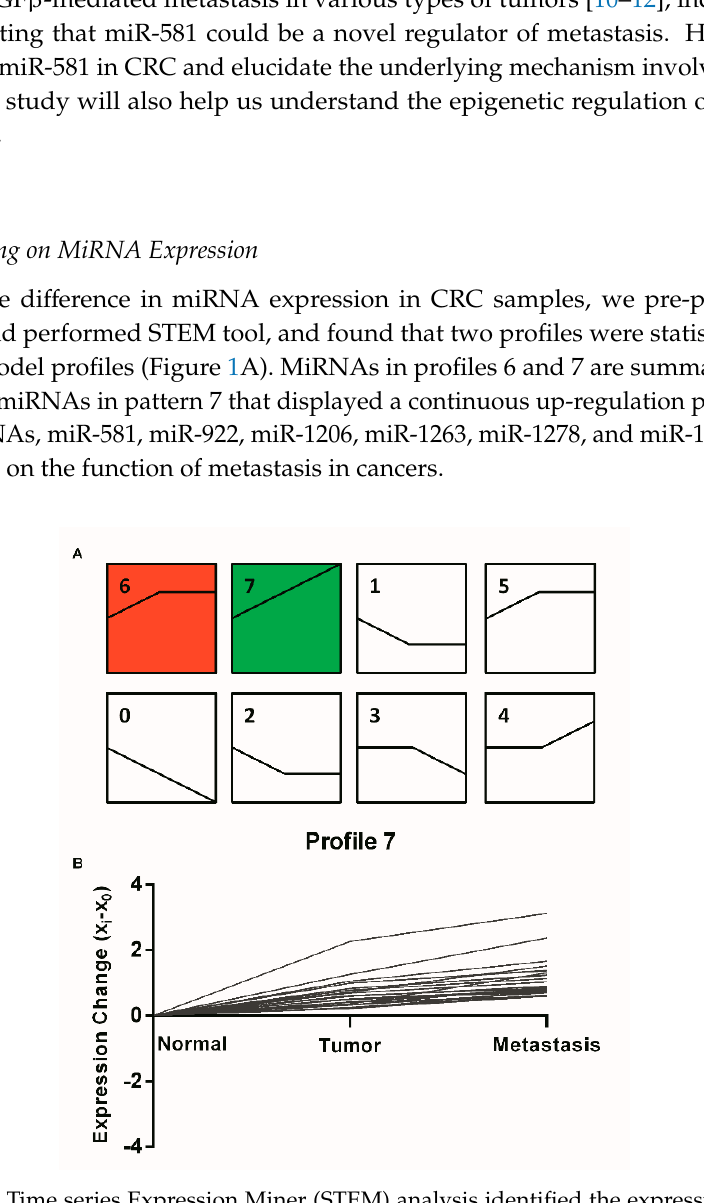
Figure 1. Short Time series Expression Miner (STEM) analysis identified the expression profiles of mRNAs. ( A ) Colored clusters indicated statistically significant numbers of genes enriched. The number in the top left represented model identifier. ( B ) In expression patterns of profile 7, each line in the figure represents an expression value of the corresponding